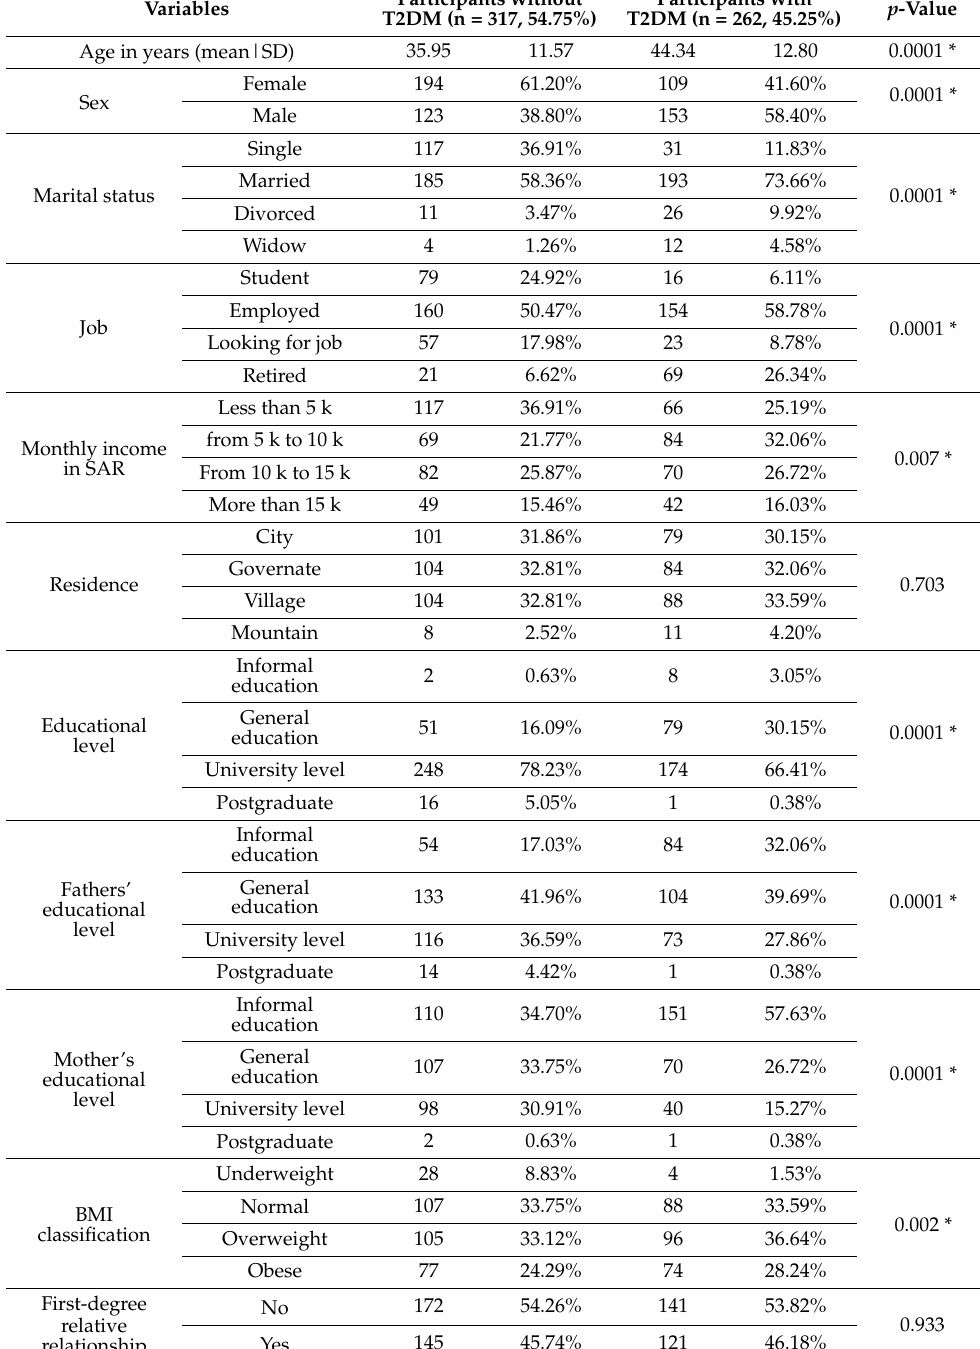
Table 2. Characteristics of the participants with type 2 diabetes mellitus compared to those without type 2 diabetes